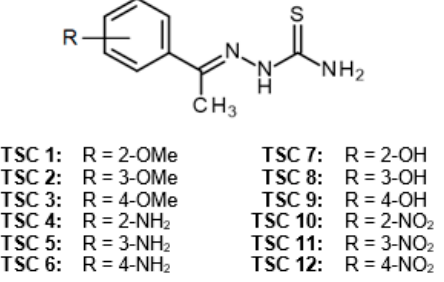
Figure 1. Chemical structures of tested thiosemicarbazone derivatives (TSCs).